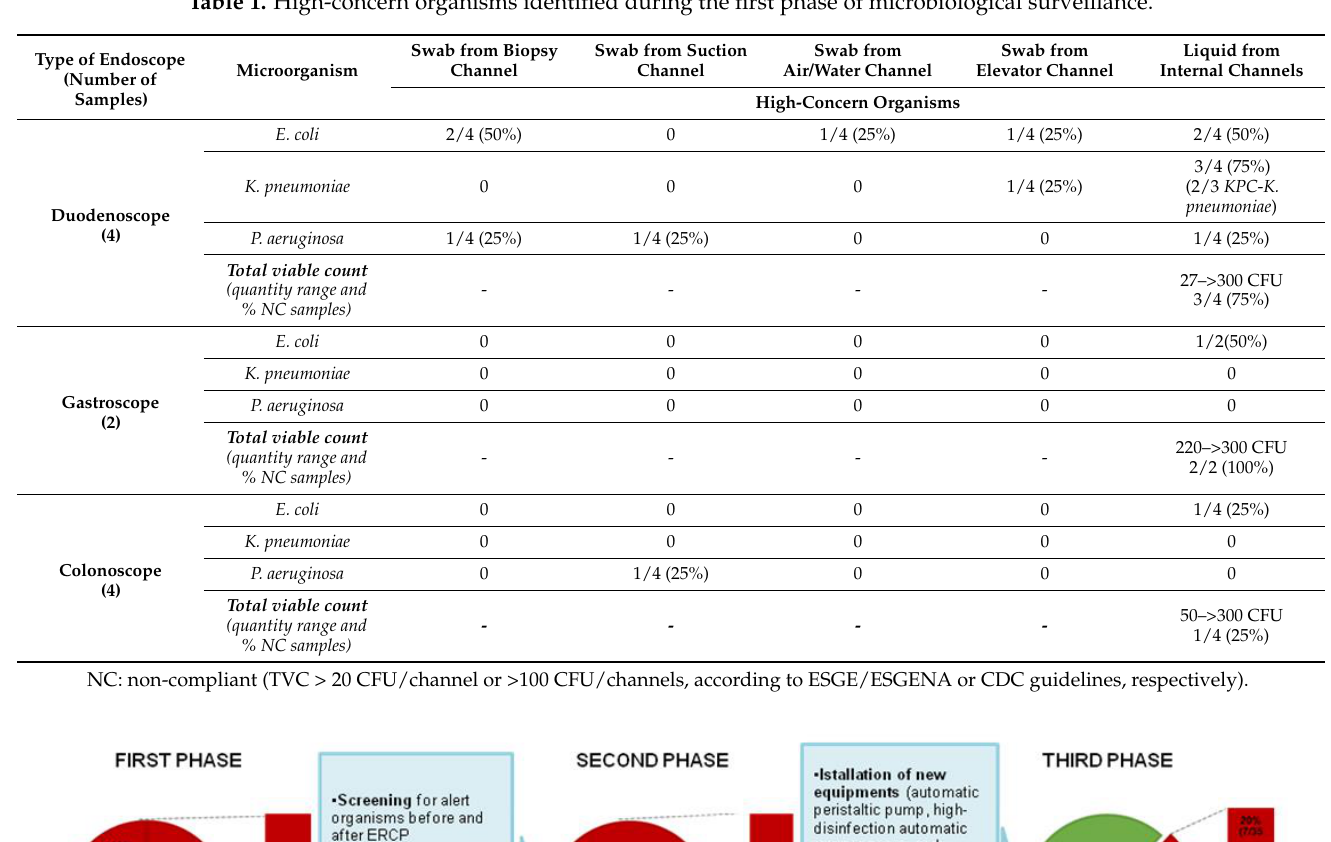
Table 1. High-concern organisms identified during the first phase of microbiological surveillance.